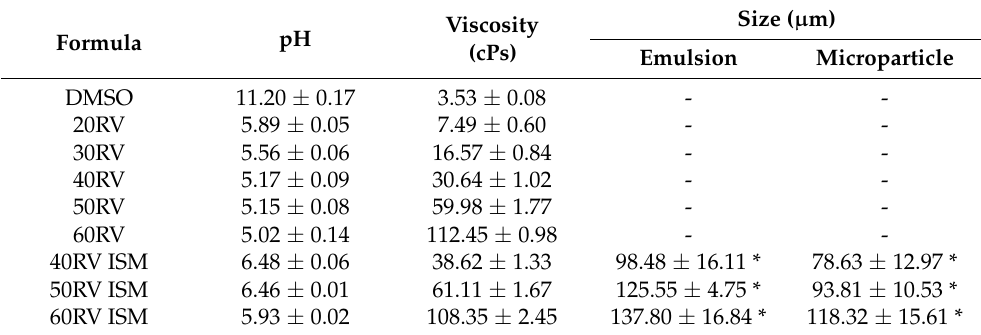
Size ( µ m) Viscosity (cPs) Emulsion Microparticle -